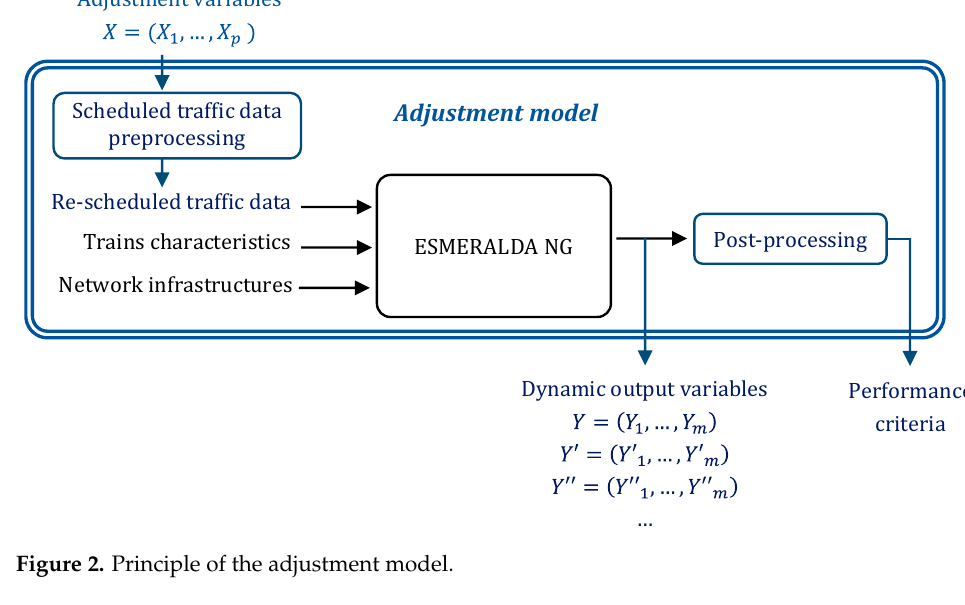
Figure 2. Principle of the adjustment model.